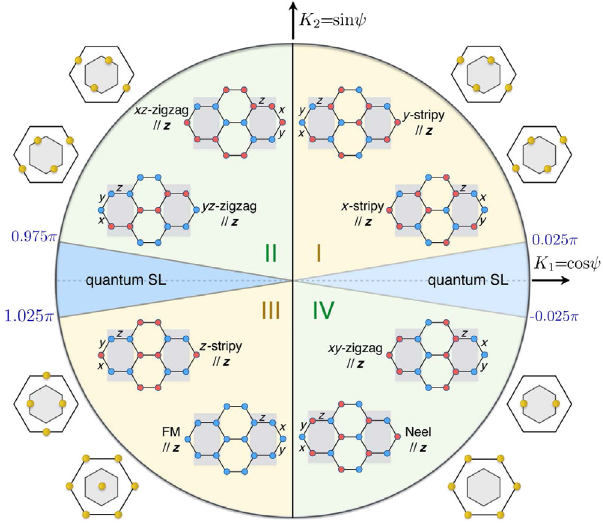
FIG. 2. The T ¼ 0 phasediagramofthemodelEq.(1)asfoundby exactdiagonalizations.Eachofthemagneticregions(I – IV)hosts12 degenerate quantum states. Here, we show two members [where spins point along the z axis, blue (red) circles denote spin-up (spin- down)] that are related to each other by flipping the spins in every second ladder (shaded strips) of Fig. 1. The Bragg peaks corre- i correlations are also shown in the extended S z sponding to h S z i j Brillouin zone (assuming the same magnetic form factor in the two unit cell sublattices). The corresponding Bragg reflections i and h S y i are related to h S z i by ~ C S x S y S z for h S x 6 v spin-orbit i j i j i j rotations